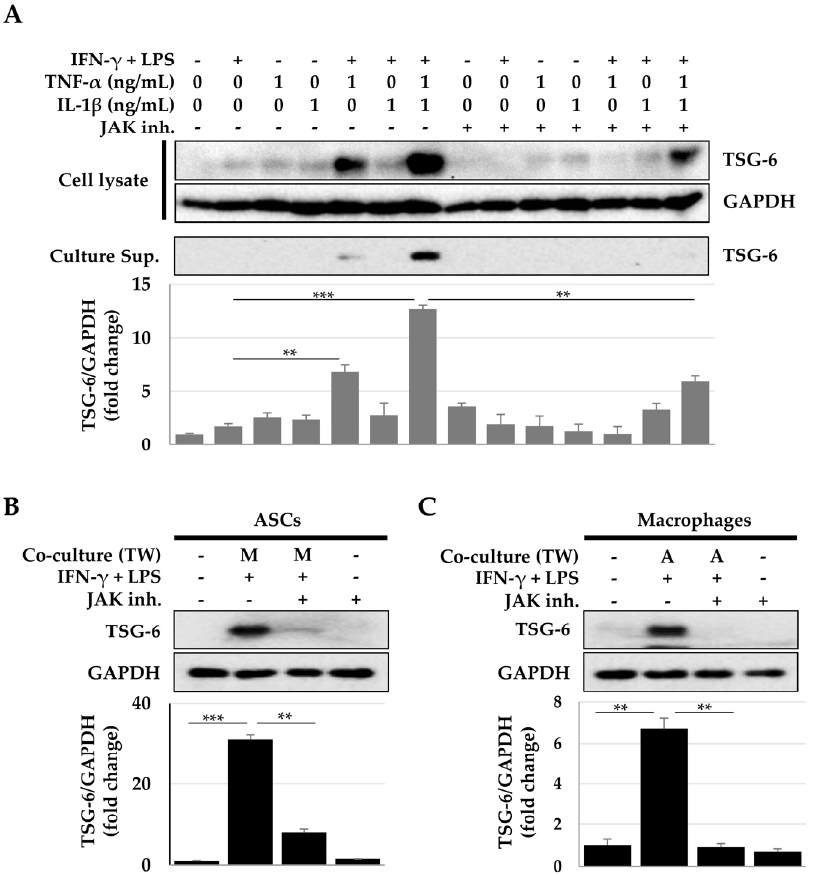
Figure 5. Inhibition of TSG-6 expression by JAK inhibitors. Cells were treated with JAK inhibitors (10 µM each of JAK1 and JAK2 inhibitor) 20 min prior to cytokine treatment or coculture. Cell lysates were recovered 48 h after stimulation, and TSG-6 expression was analyzed using immunoblotting.